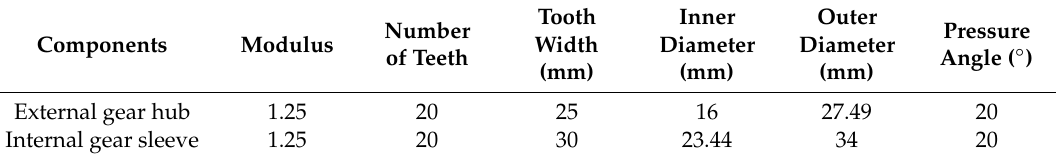
Table 1. Basic structure parameters of adopted gear coupling.